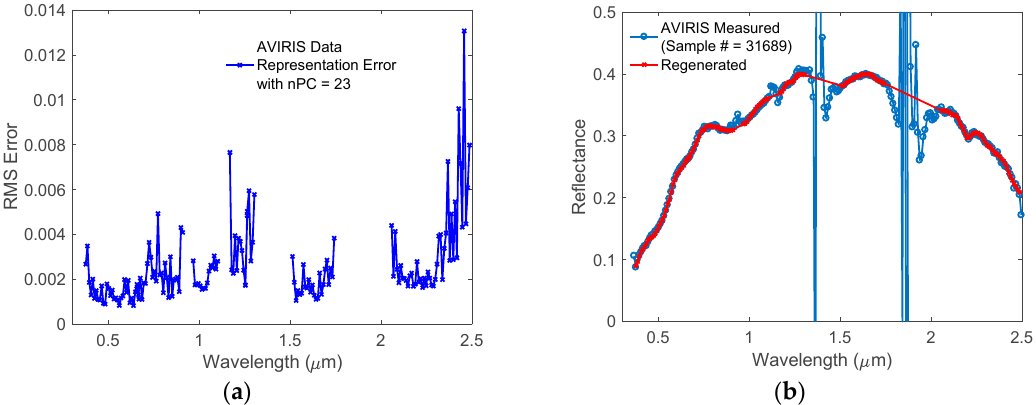
Figure 3. Representativeness of the simulated BRDFs validated using AVIRIS data. ( a ) Root mean square (RMS) error of the regenerated AVIRIS reflectances from a linearly combination of 23 PCs obtained from the simulated training data; ( b ) Randomly selected AVIRIS measured reflectance spectrum vs. the regenerated spectrum.